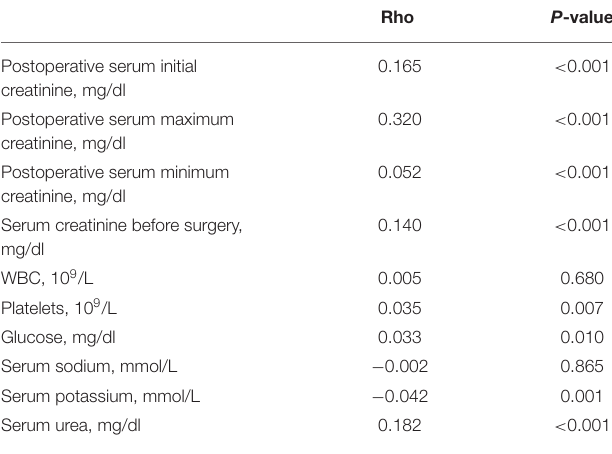
TABLE 2 | The correlation of laboratory events with lengths of intensive care unit (ICU)